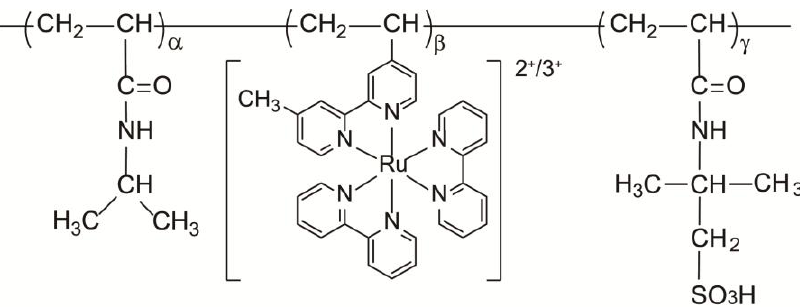
Figure 1. Chemical structure of poly(NIPAAm- co -Ru(bpy)